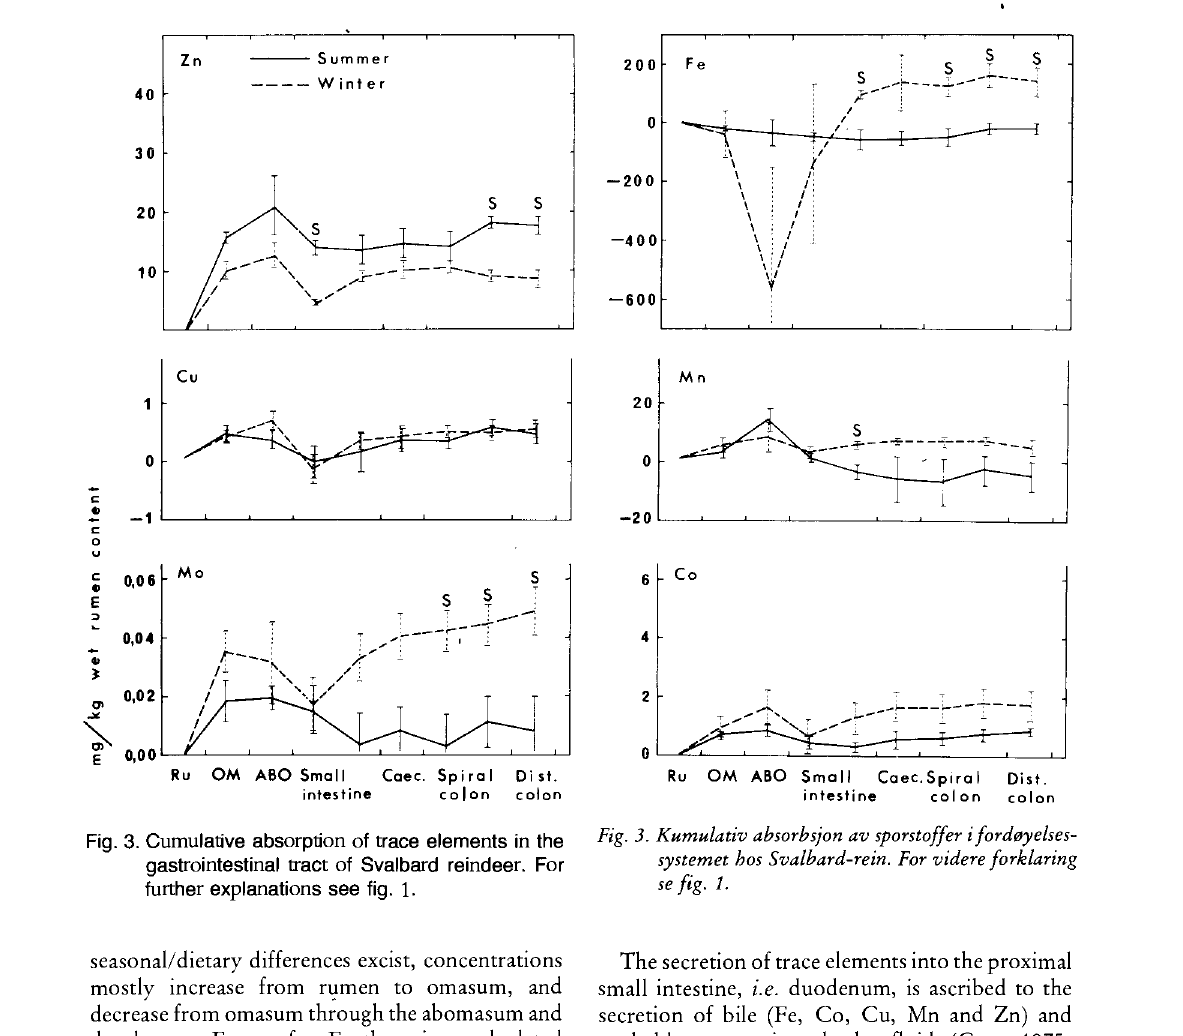
Fig. 3. Cumulative absorption of trace elements in the gastrointestinal tract of Svalbard reindeer. For further explanations see fig. 1.